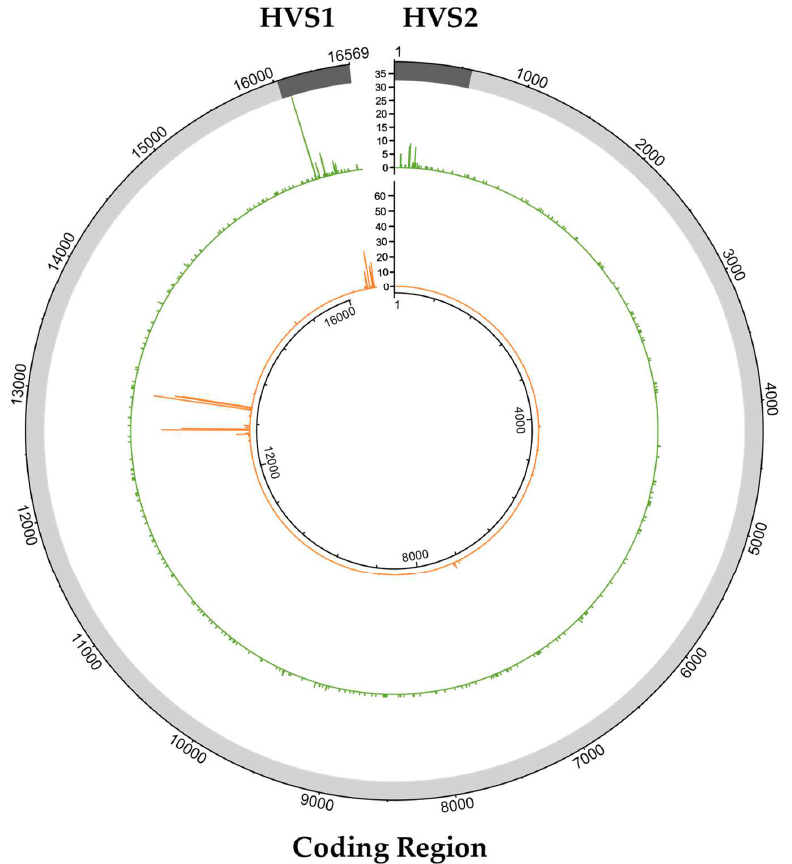
Figure 3. Distribution of mixed positions across the circular mitogenome, including the hypervariable segments 1 and 2 (HVS1 and HVS2, respectively; dark gray) of the mtDNA control region and the entire mtDNA coding region (light gray). These 833 mixed positions were detected with a 5% minor nucleotide frequency threshold and classified as either a NUMT variant or PHP. The 413 NUMT variants are shown in the inner plot (orange; scale 0–60 observations) and the 420 PHPs are displayed in the outer plot (green; scale 0–35 observations).